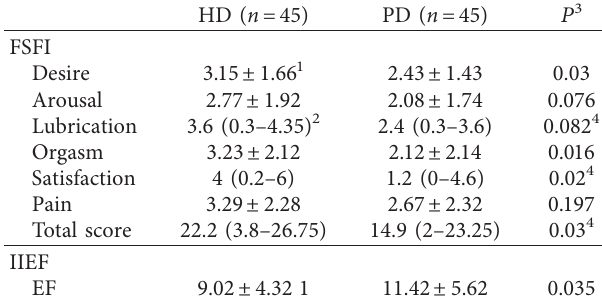
Table 3: Comparison of FSFI scores and EF scores of IIEF between HD and PD groups.